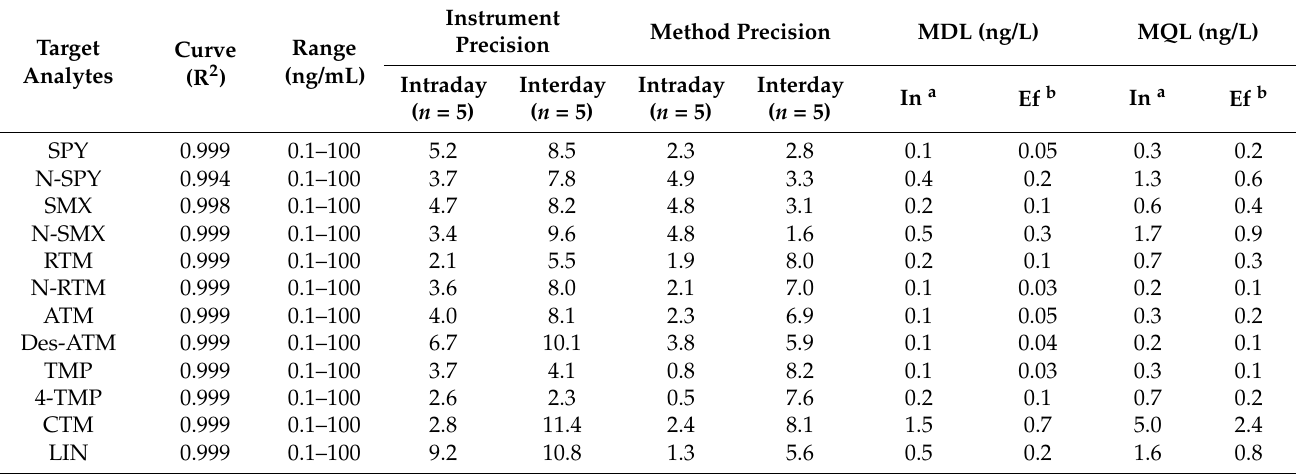
Table 1. Inter/intra-day precision (RSD%), method precision (RSD%), linearity of calibration curves (R 2 ), method detection limit (MDL), method quantitation limit